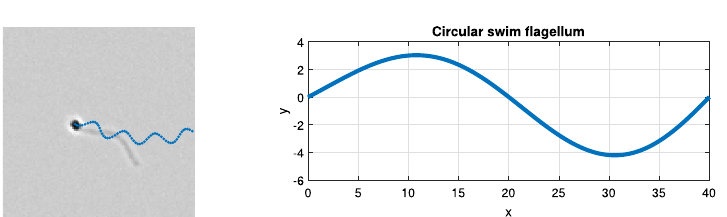
Figure 13. (Left) Simulated image of circular swimming cell with past track shown in blue. (Right) Plot of the flagellum of circular swimming cell. In this example, wavelength ( (cid:31) ) is 40 pixels and amplitude ( a ) is 4